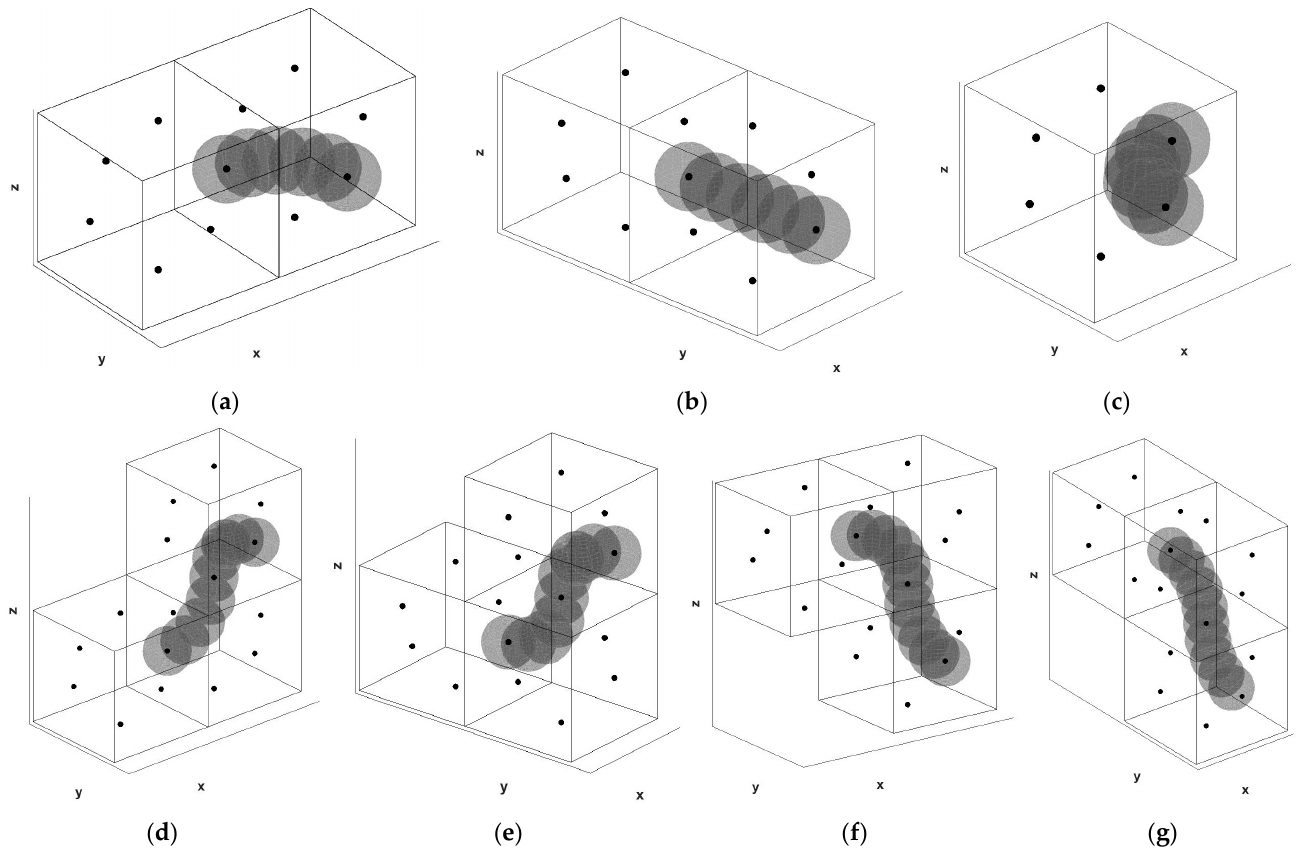
Figure 4. Possible movements of a UAV in the intersection ( a ) Turn left on the same layer ( b ) Move forward on the same layer ( c ) Turn right on the same layer ( d ) Move down then turn left ( e ) Move down then forward ( f ) Move up then turn left ( g ) Move up then forward.